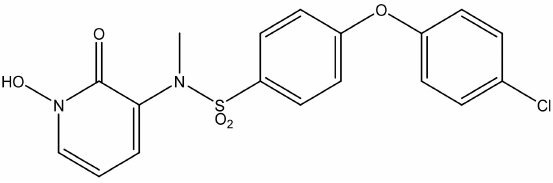
Figure 13. Best inhibitor synthesized by Zhang et al. [53].